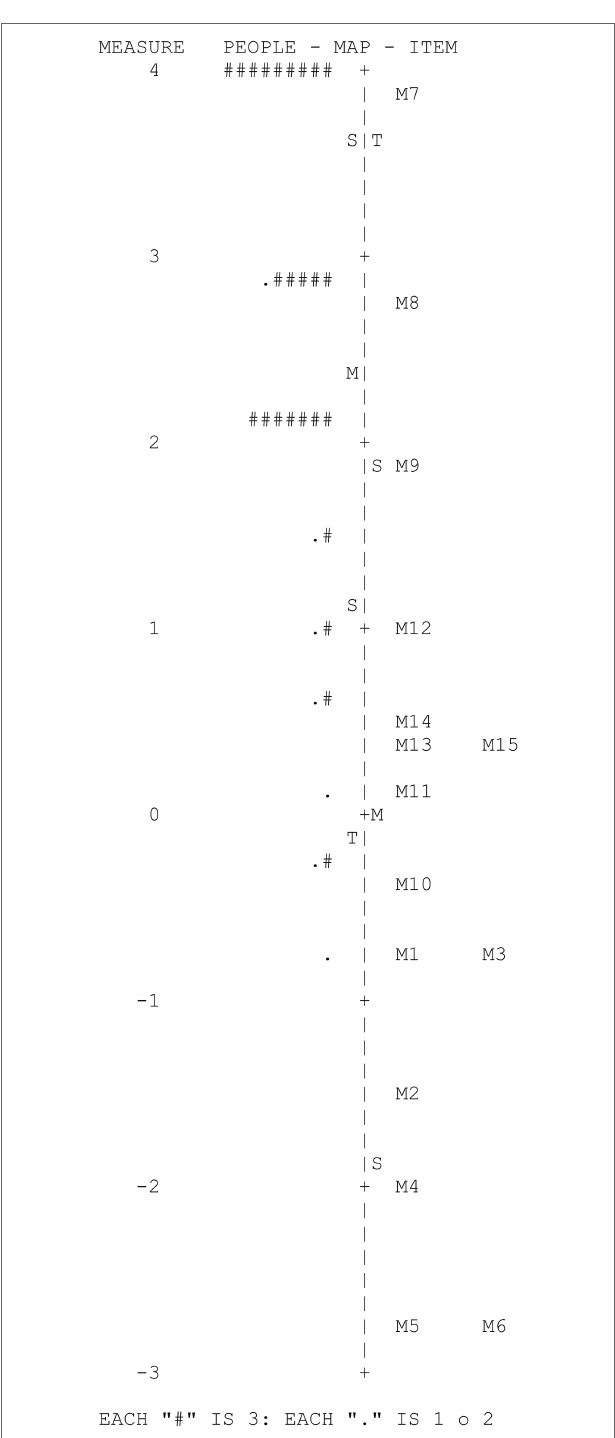
FIGURE 2 | CAPALIST-memory. Variable